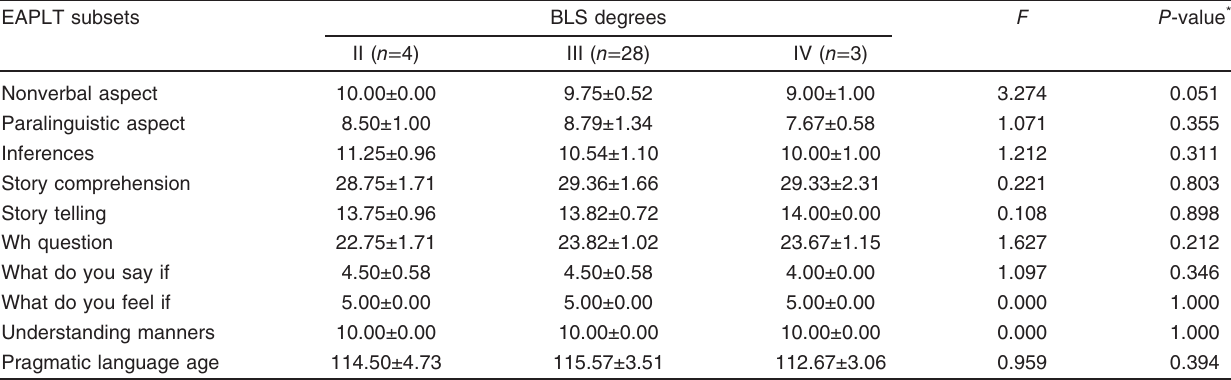
Table 10 Relation between stuttering severity measured by Bloodstein degree and pragmatic language development in children in age group III (8 years 1 month 1 day to 9 years 12 month 31 days) using independent sample analysis of variance test EAPLT subsets